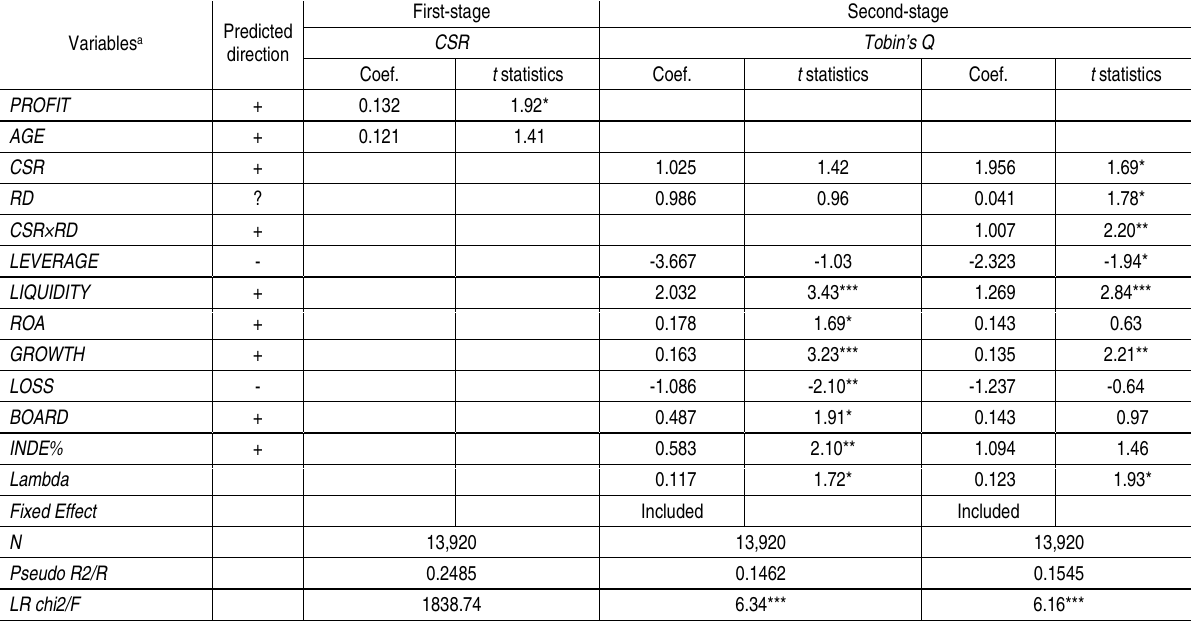
Table 5 (cont.). The association between CSR engagement and firm performance － Heckman two